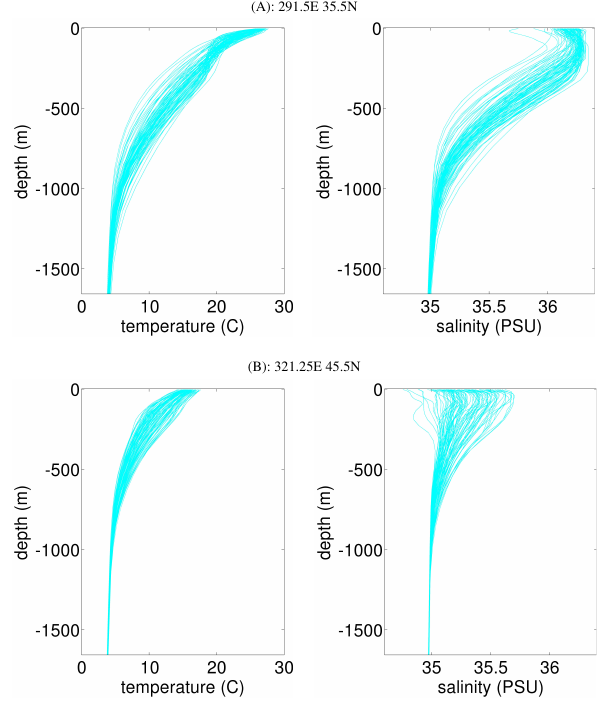
Figure 3. Local profiles, 96-member ensemble for temperature (left column) and salinity (right column), 9 July